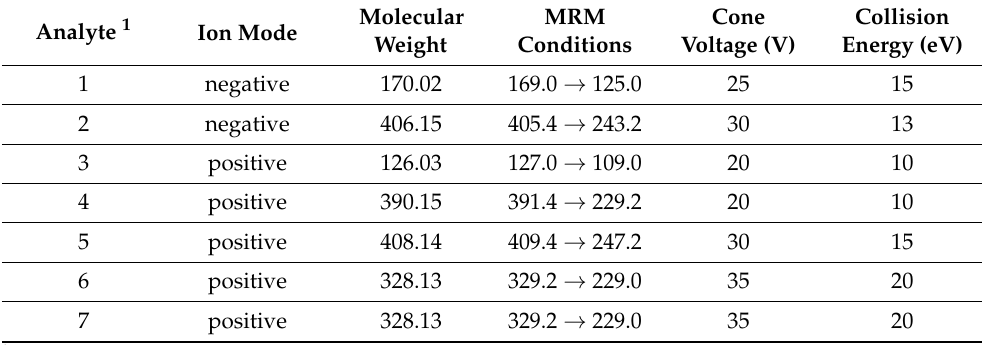
Table 1. Parameters for UPLC–MS/MS MRM analysis of the seven